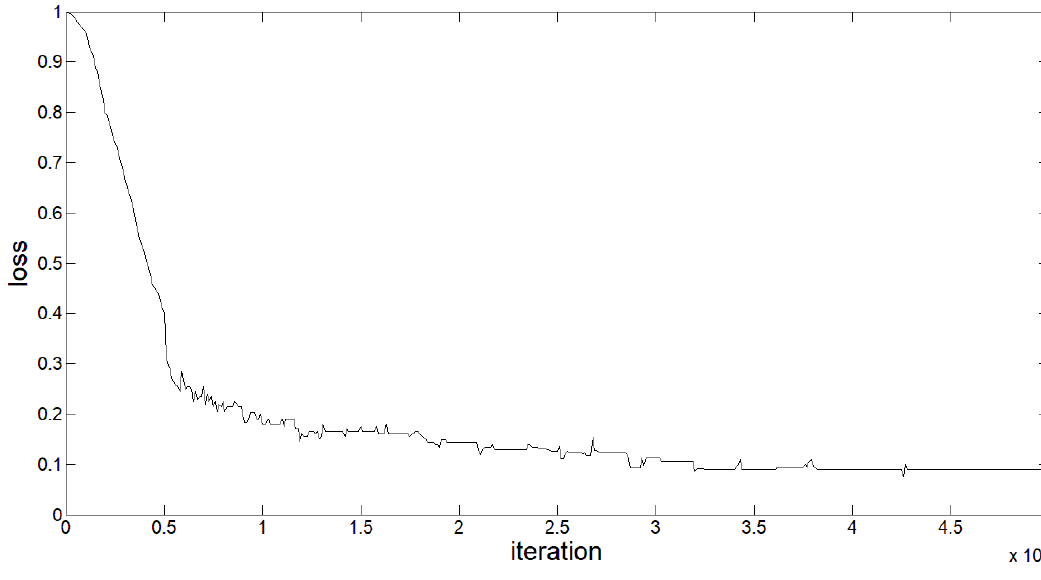
Figure 4. The training curve of loss function based on weight